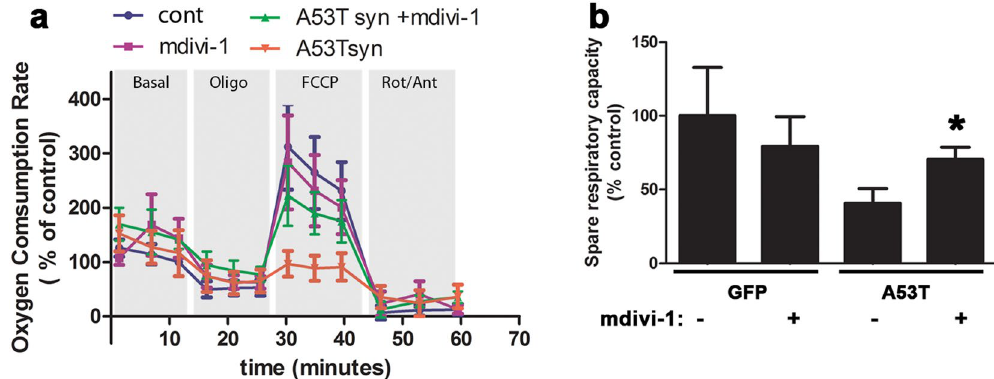
Figure 5. Mdivi-1 attenuates mitochondrial dysfunction in isolated synaptosomes. Mitochondrial function in striatal synaptosomes was assessed by measuring oxygen consumption rate (OCR) using the XFe96 Extracellular Flux Analyzer. ( a ) Sequential injections of oligomycin (to inhibit oxygen consumption mediated by ATP synthase), FCCP (an uncoupler to induce maximal OCR), Rotenone/Antimycin (to inhibit complex I and III, respectively). Values obtained from ( a ) were then used to calculate Spare Respiratory Capacity as a % = (Maximal Respiration)/(Basal Respiration) × 100 ( b ). Data represent means ± SEM of 5 five animals per group (except for the GFP + mdivi-1 group, n = 3), Statistical analysis was performed using two-way ANOVA (AAV injection: F 1,14 = 26.12 p < 0.001; treatment: F 1,14 = 4.07 p = 0.063; AAV injection x treatment: F 1,14 = 1.19 p = 0.294) followed by Tukey multiple comparison test ( * p < 0.05 to A53T α -syn localizes to organelles such as lysosomes, endoplasmic reticulum and mitochondria. Indeed, it has been well-reported that α -syn impairs the function of these organelles. Combined with its ability to inhibit the ubiquitin-proteosomal and autophagic pathways, protein aggregation is a common observation in α -syn asso- ciated toxicity. In addition to these cell-autonomous mechanisms, α -syn also activates microglia and induces